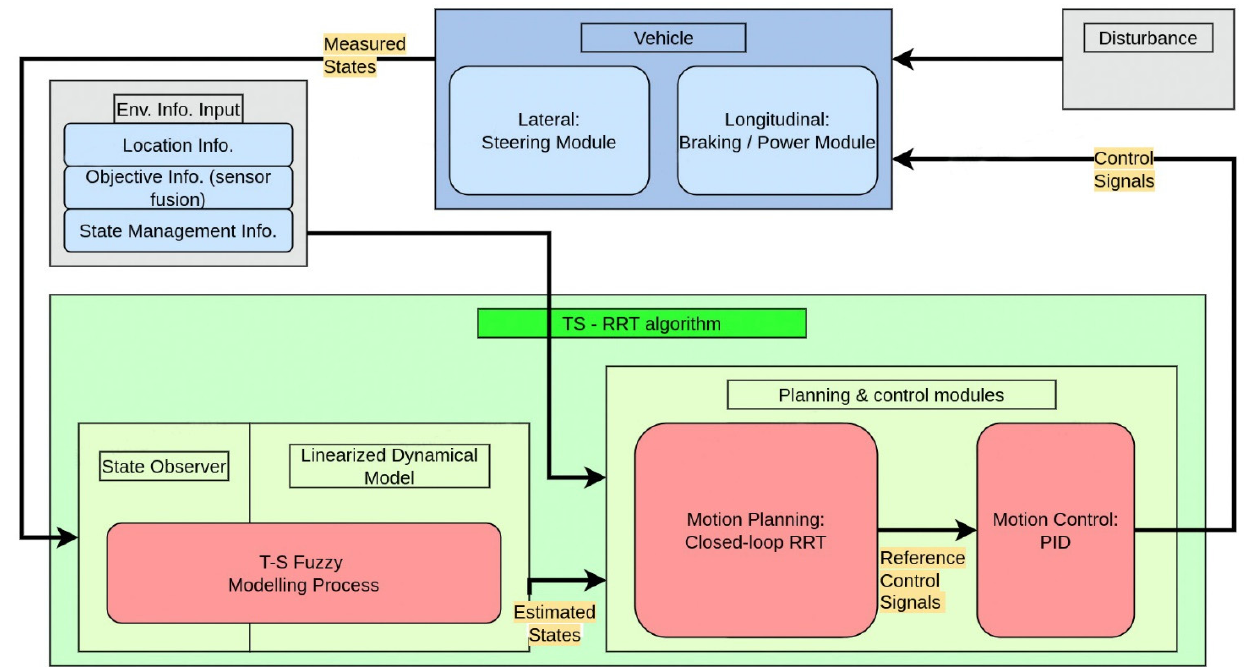
Figure 2. The control flow of the closed-loop system.